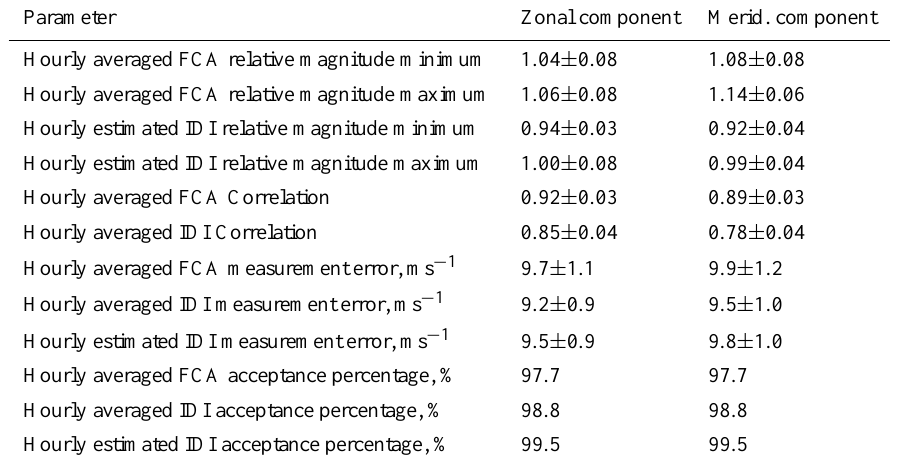
Table 4. Mean and standard deviation of daily relative magnitude minima and maxima, and correlations for hourly estimate IDI and hourly averaged FCA-large velocities with respect to hourly averaged IDI velocities for 20 August 2000 to 19 September 2003. Parameter Zonal component Merid.